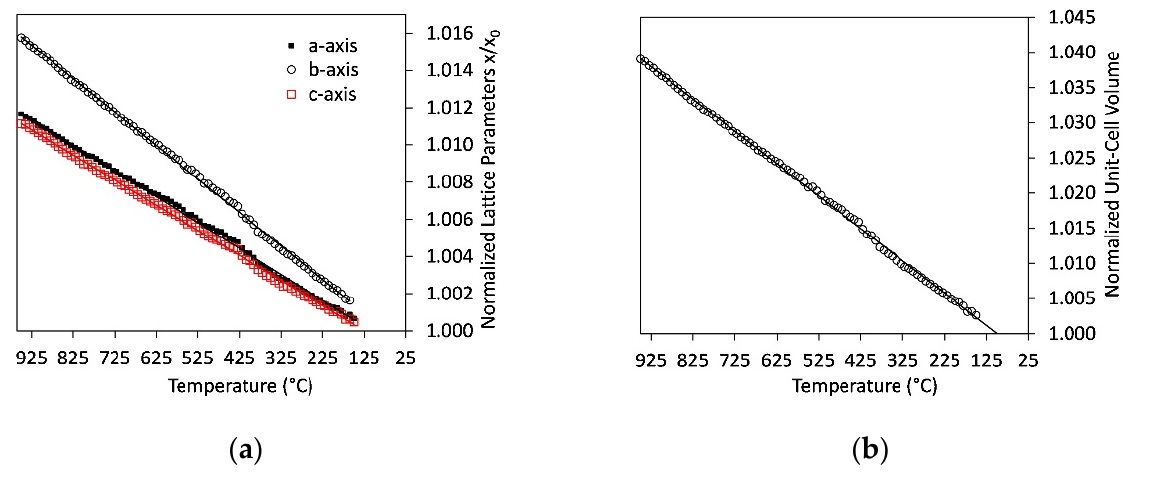
Figure 7. Temperature-dependent variation of lattice parameters of ternesite (experiment D3_step10) normalized to the parameters at ambient conditions. ( a ) a -, b , and c -axis and ( b ) unit-cell volume. Errors for the normalized lattice parameters are 0.0002 and for the normalized volume 0.0003.